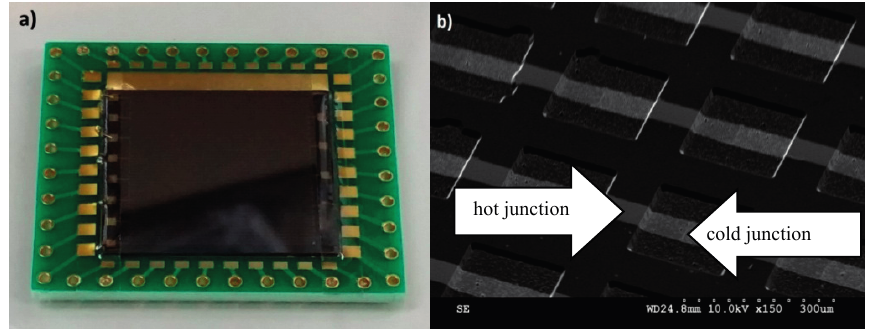
Figure 4. ( a ) Optical picture of the chip calorimeter bonded on a PCB; ( b ) SEM image of the hot and cold junctions of the thermopiles.